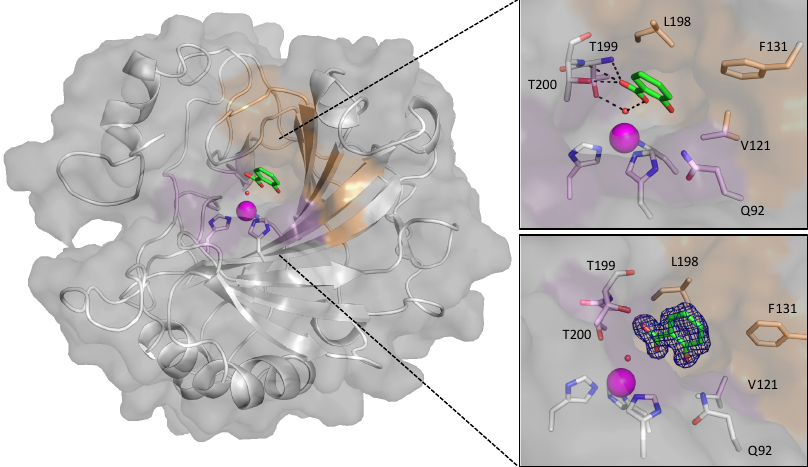
Figure 1. Structure of carbonic anhydrase II (CAII) complexed with salicylic acid (SA). The hydrophobic face of CAII is shown as the orange surface while the hydrophilic face is shown as violet. Zinc is depicted as a magenta sphere with critical binding residues shown in sticks. Bound salicylic acid is shown in green sticks. Top insert, active site with SA interactions and hydrogen bonds shown in dashes; bottom insert, electron density for SA shown as blue mesh. PDB: 6UX1.